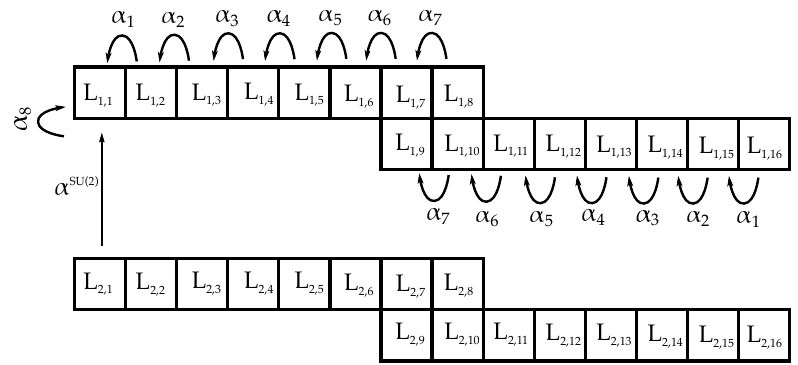
Figure 1. The representation graph (or undecorated box graph) for the ( 2 ; 16 ) representation of SU(2) gauge (cid:2) SO(16). The simple roots of SO(16) are (cid:11) i , and for SU(2) gauge the simple root is (cid:11) SU(2) . The arrows indicate how weights are mapped into each other under the addition of the roots. The weights are L i;j = L 2 + L 16 , where L R are the fundamental weights of the representation i j i R . The action of the roots is indicated by the arrows. Note that L 16 = (cid:0) L 16 for i = 1 ; : : : ; i +8 9 (cid:0) i